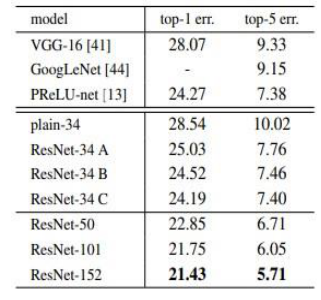
Table 3. Error rate of various models